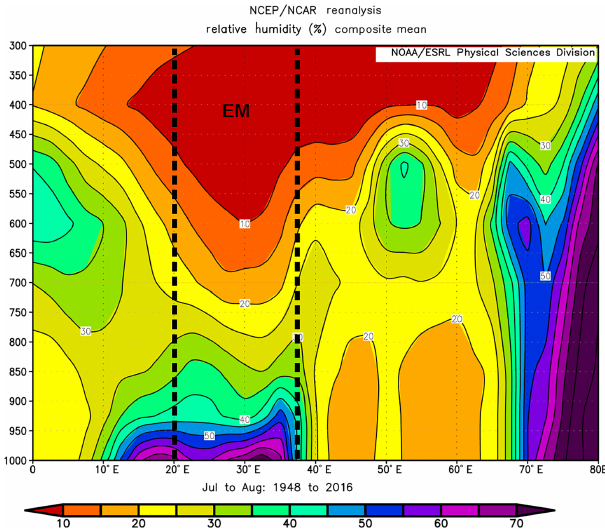
Figure 6. Long-term mean vertical cross section of relative hu- midity, averaged over the 31–36 ◦ N latitudinal band for July– August 1948–2016 with the eastern Mediterranean position, in dashed black lines. NCEP reanalysis data are provided by the NOAA/OAR/ESRL PSD, Boulder, Colorado, USA; http://www.